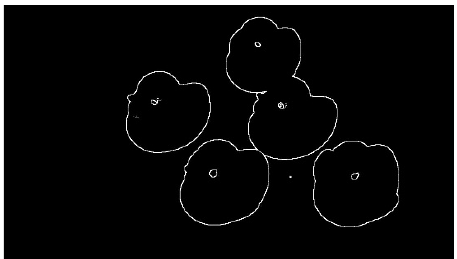
Figure 10. Result of edge extraction for the gray image processed by fuzzy mathematical